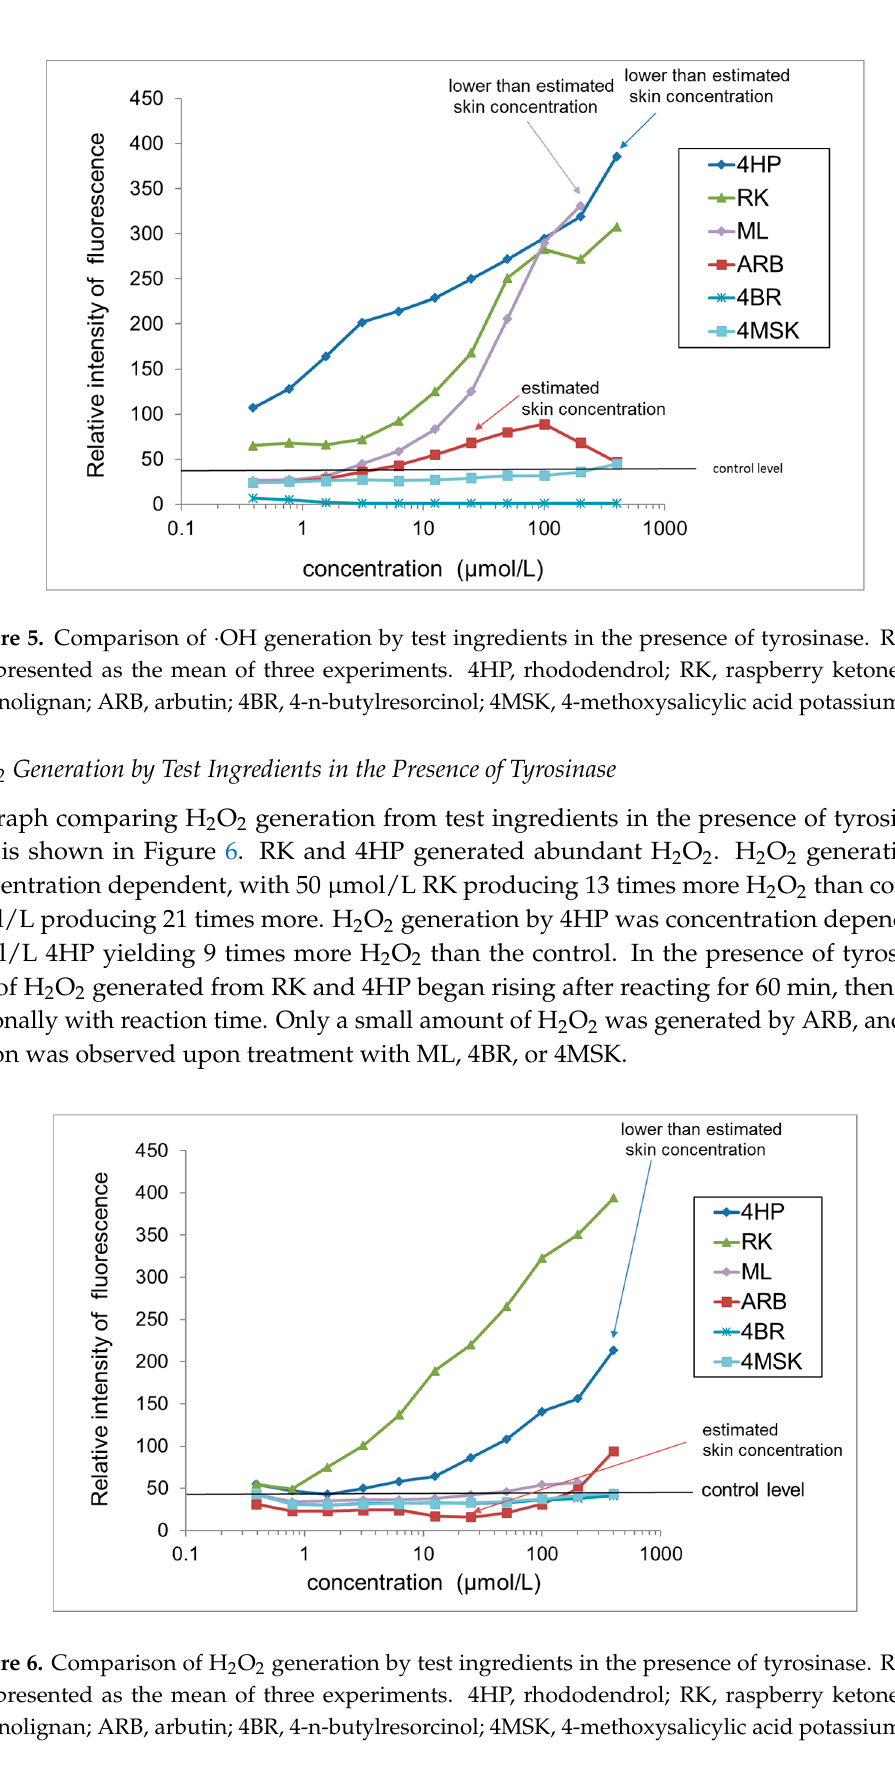
10 of 16 ( e ) Figure 4. Electron micrographs (3000×) of pigment cells treated with 4HP (125 µmol/L), RK (125 µmol/L), ML (25 µmol/L), or 4BR (50 µmol/L). 4HP, rhododendrol; RK, raspberry ketone; ML, magnolignan; ARB, arbutin; 4BR, 4-n-butylresorcinol: ( a ) Control; ( b ) 4HP (125 µmol/L); ( c ) RK (125 µmol/L); ( d ) ML (25 µmol/L); ( e ) 4BR (50 µmol/L). 3.7. Hydroxyl Radical ( ∙ OH) Generation from Test Ingredients in the Presence of Tyrosinase A graph comparing ∙ OH generation by active test ingredients in the presence of tyrosinase after 30 min is shown in Figure 5. 4HP, RK, and ML were found to generate ∙ OH in a concentration- dependent manner in the presence of tyrosinase, peaking at 30 min and then remaining constant. Compared to controls, ∙ OH generation from 3 µmol/L 4HP was 5 times greater and that from 300 µmol/L was 10 times greater. RK and ML at 200 µmol/L also produced ∙ OH 10 times that in the controls. In addition, abundant ∙ OH generation was detected at concentrations lower than the estimated skin concentrations of 4HP (2567 µmol/L) and ML (3461 µmol/L). ∙ OH generation from ARB at the estimated skin concentration (37.4 µmol/L) was small, approximately 2 times greater than that in the control. The ∙ OH generation was not observed at the estimated skin concentrations of 4BR